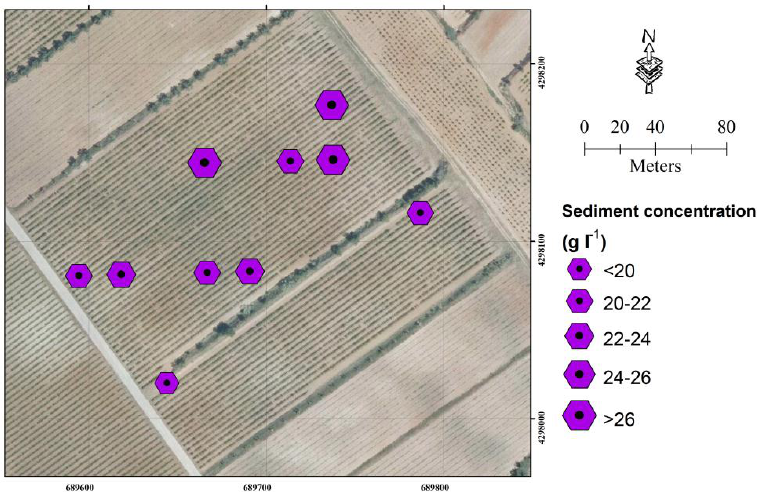
Figure 6. Spatial distribution of soil erosion rates.